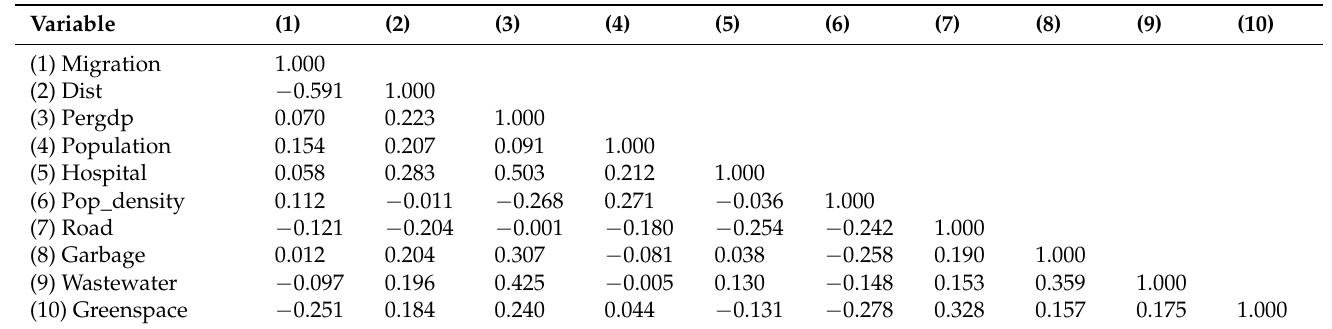
Table 2. Correlations between explanatory